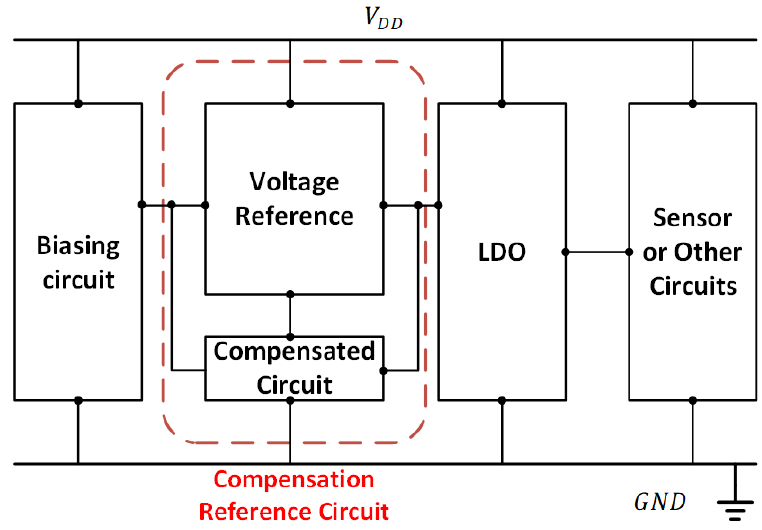
Figure 1. Exemplary Electronic System with High-order Temperature Compensated Voltage Refer- ence.